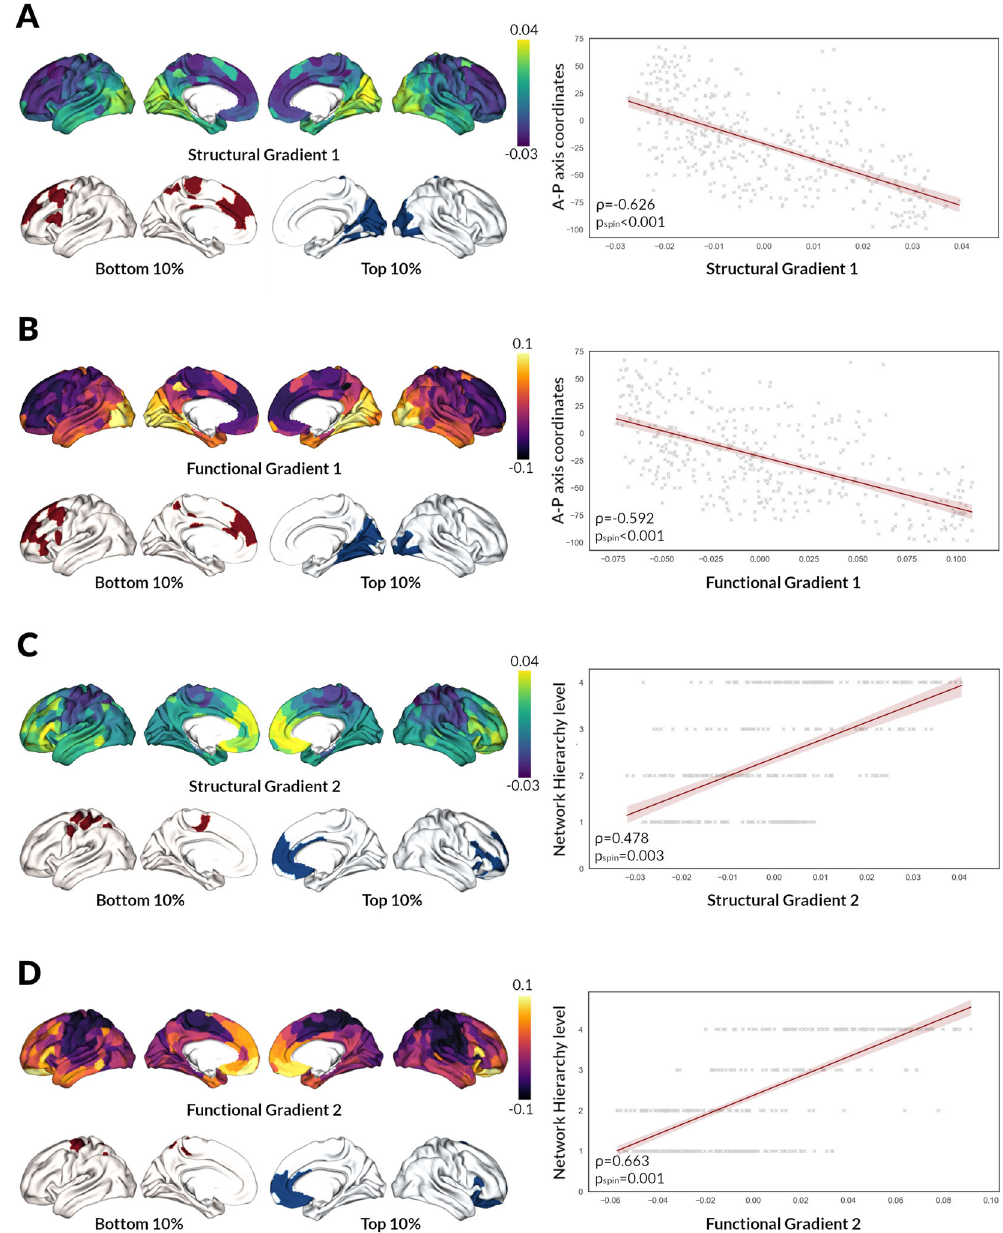
Fig. 3 Structural and functional gradients of cortical organisation in controls. The fi rst two principal gradients derived from the averaged control structural and functional connectivity matrices are presented. Gradient scores are projected back onto the cortical surface. The fi rst principal structural ( A ) and functional ( B ) gradients showed a dissociation between the posterior and anterior regions. The second principal structural ( C ) and functional ( D ) gradients showed a dissociation between unimodal and transmodal regions. Top and bottom 10% of the average control gradients highlight regions with similar (same colour) and distinct (red vs blue) connectivity pro fi les. For the fi rst structural and functional gradients, top 10% of regions are more posterior and bottom 10% more anterior. For the second structural and functional gradients, top 10% of regions are more transmodal and bottom 10% more unimodal. On the right, we plot the correlation between the gradient score (control-averaged) and the A – P axis coordinate for the fi rst principal gradients, and the Network Hierarchy level for the second principal gradients (each dot represents a single region of the average control connectome). A – P: Anterior – Posterior (lower values representing more posterior regions, higher values more anterior regions), Network Hierarchy level: level 1 sensory and sensorimotor networks, level 2 dorsal attention and salience networks, level 3 frontoparietal and limbic networks, level 4 default mode network post-mortem studies 64 showing serotoninergic degeneration in PD. In contrast, in PD low visual performers SC – FC decoupling was more prominent in regions with increased serotoninergic receptor expression, speci fi cally HTR1E and HTR5A . Although the function of these receptors is not yet fully described, HTR5A is thought to have a role in cognition 65 , with 5HT-5a antagonists improving cognition in animal models 66 .